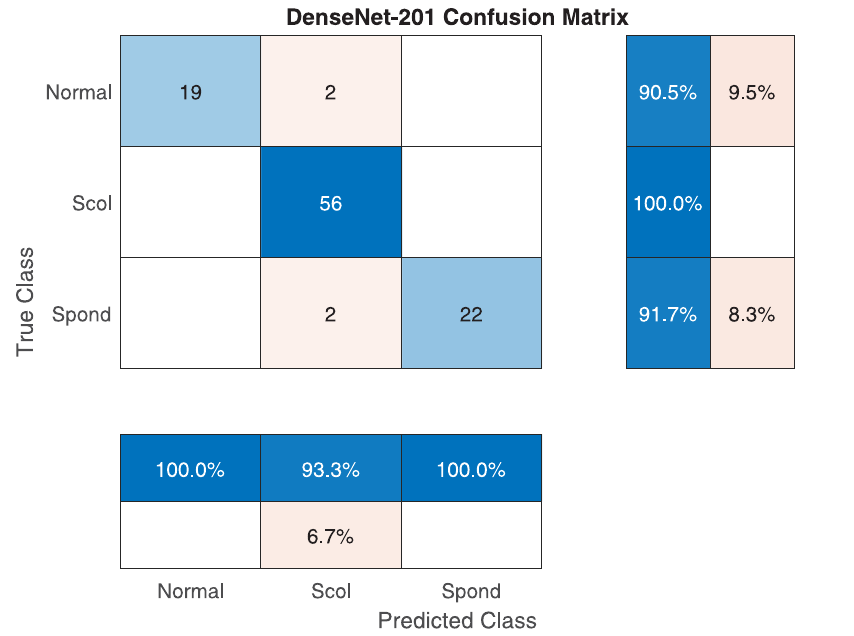
Fig 3. The DenseNet-201 sample confusion matrix for three-class classification.